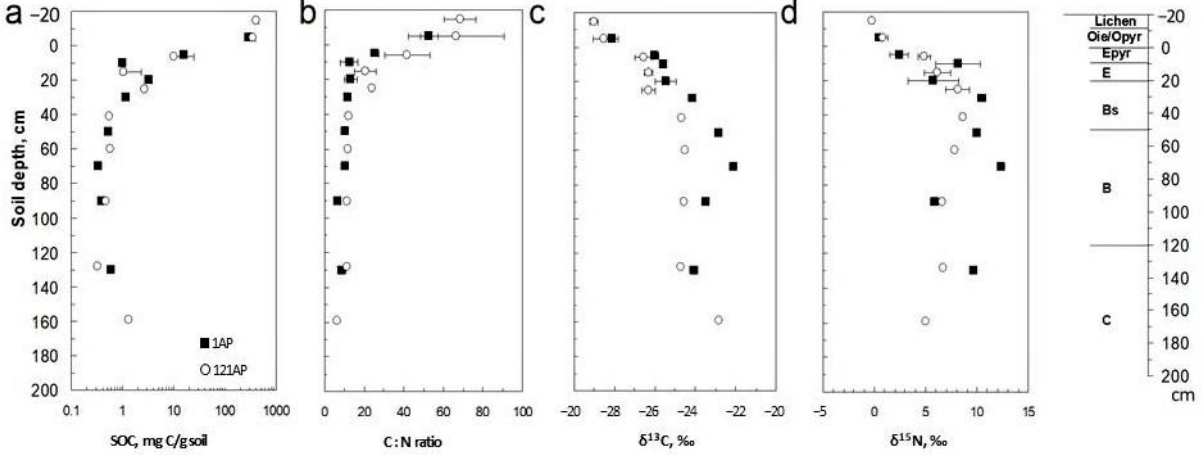
Figure 3. Changes of SOC content ( a ), C:N ratio ( b ), δ 13 C-SOC ( c ) and δ 15 N ( d ) with soil depth in pine forests affected by wildfires 1 and 121 years ago.